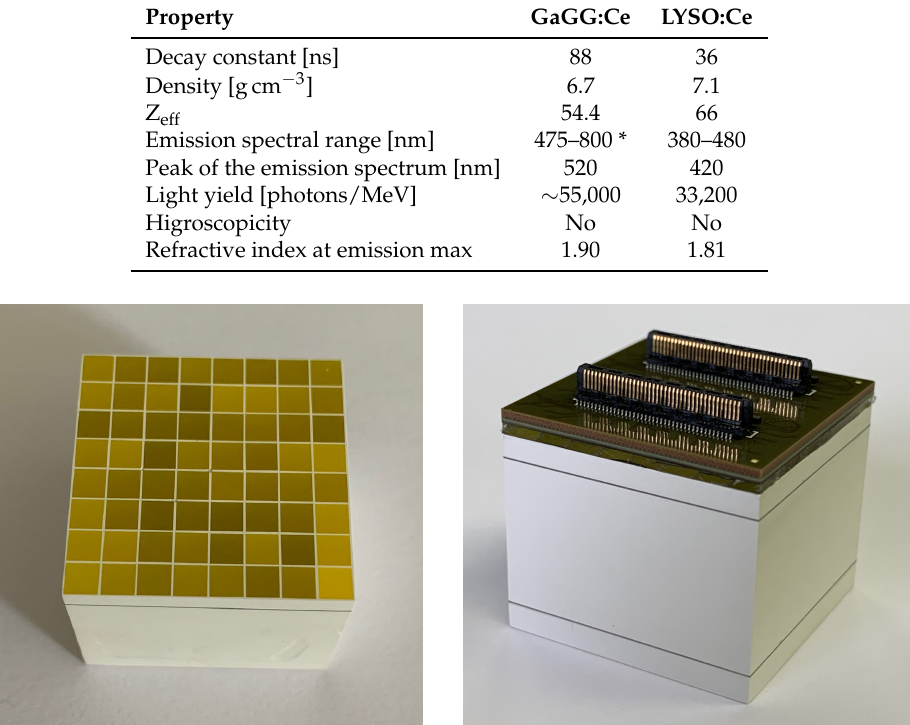
Figure 1. GaGG:Ce matrix containing 64 crystals with a size of 3 mm × 3 mm × 20 mm in 8 × 8 configuration. All crystal sides were polished and casted in 0.2 mm of white epoxy ( left ). GaGG:Ce matrix along with the SiPM array optically coupled with a silicon optical interface ( right